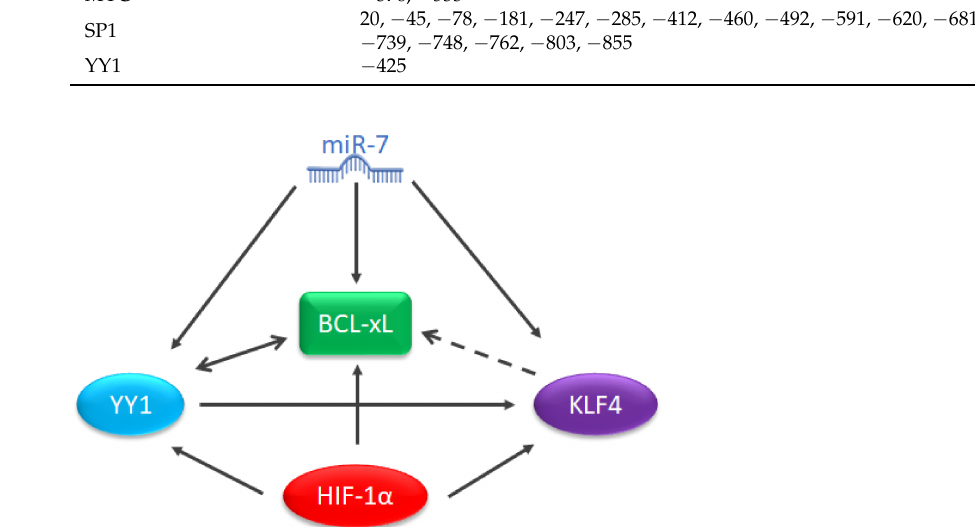
Figure 9. Proposal for a potential regulatory environment for BCL-xL. Schematic proposal or a regulatory environment of